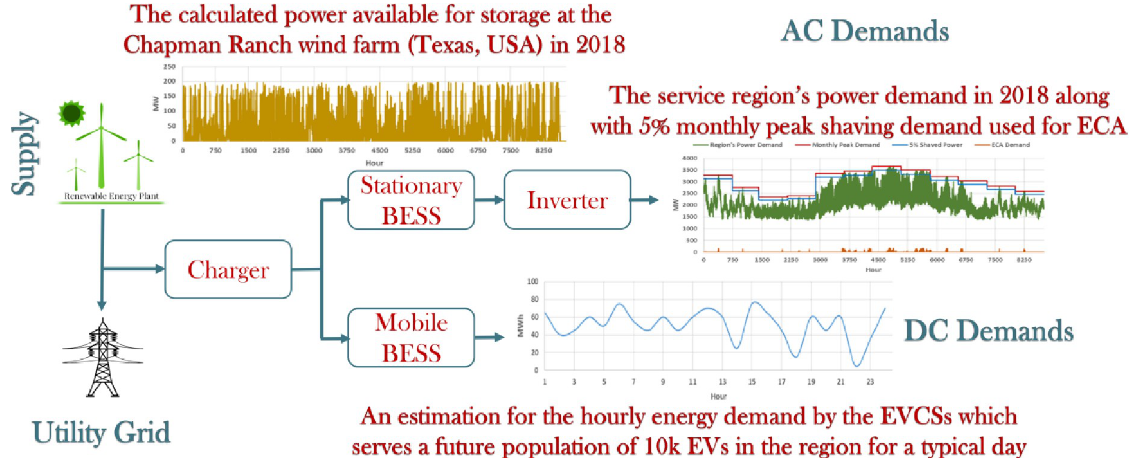
Fig 3. Diagram of the conceptual BESS model with the proposed applications. Better resolutions for the embedded figures are available in Fig 4.